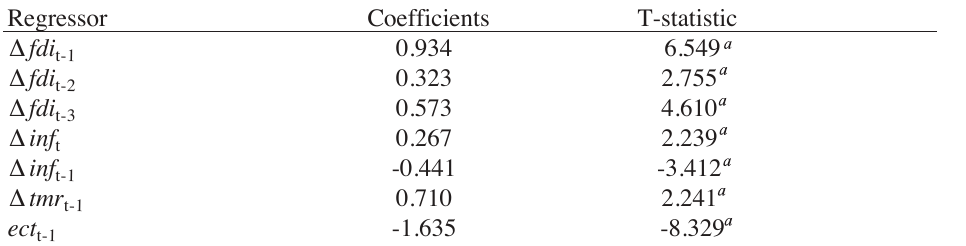
Table 5.4 Error Correction Representation of ARDL Model.